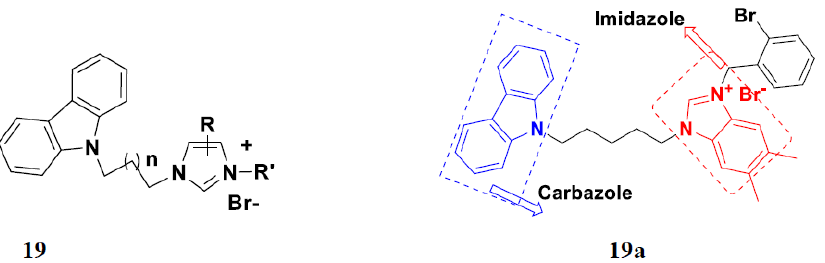
Figure 22. Structure of carbazole ‐ imidazole based hybrids and the most promising compound 19a. Table 20. In vitro cytotoxic activities of carbazole ‐ imidazole based hybrid compounds 19 ( b – e ).